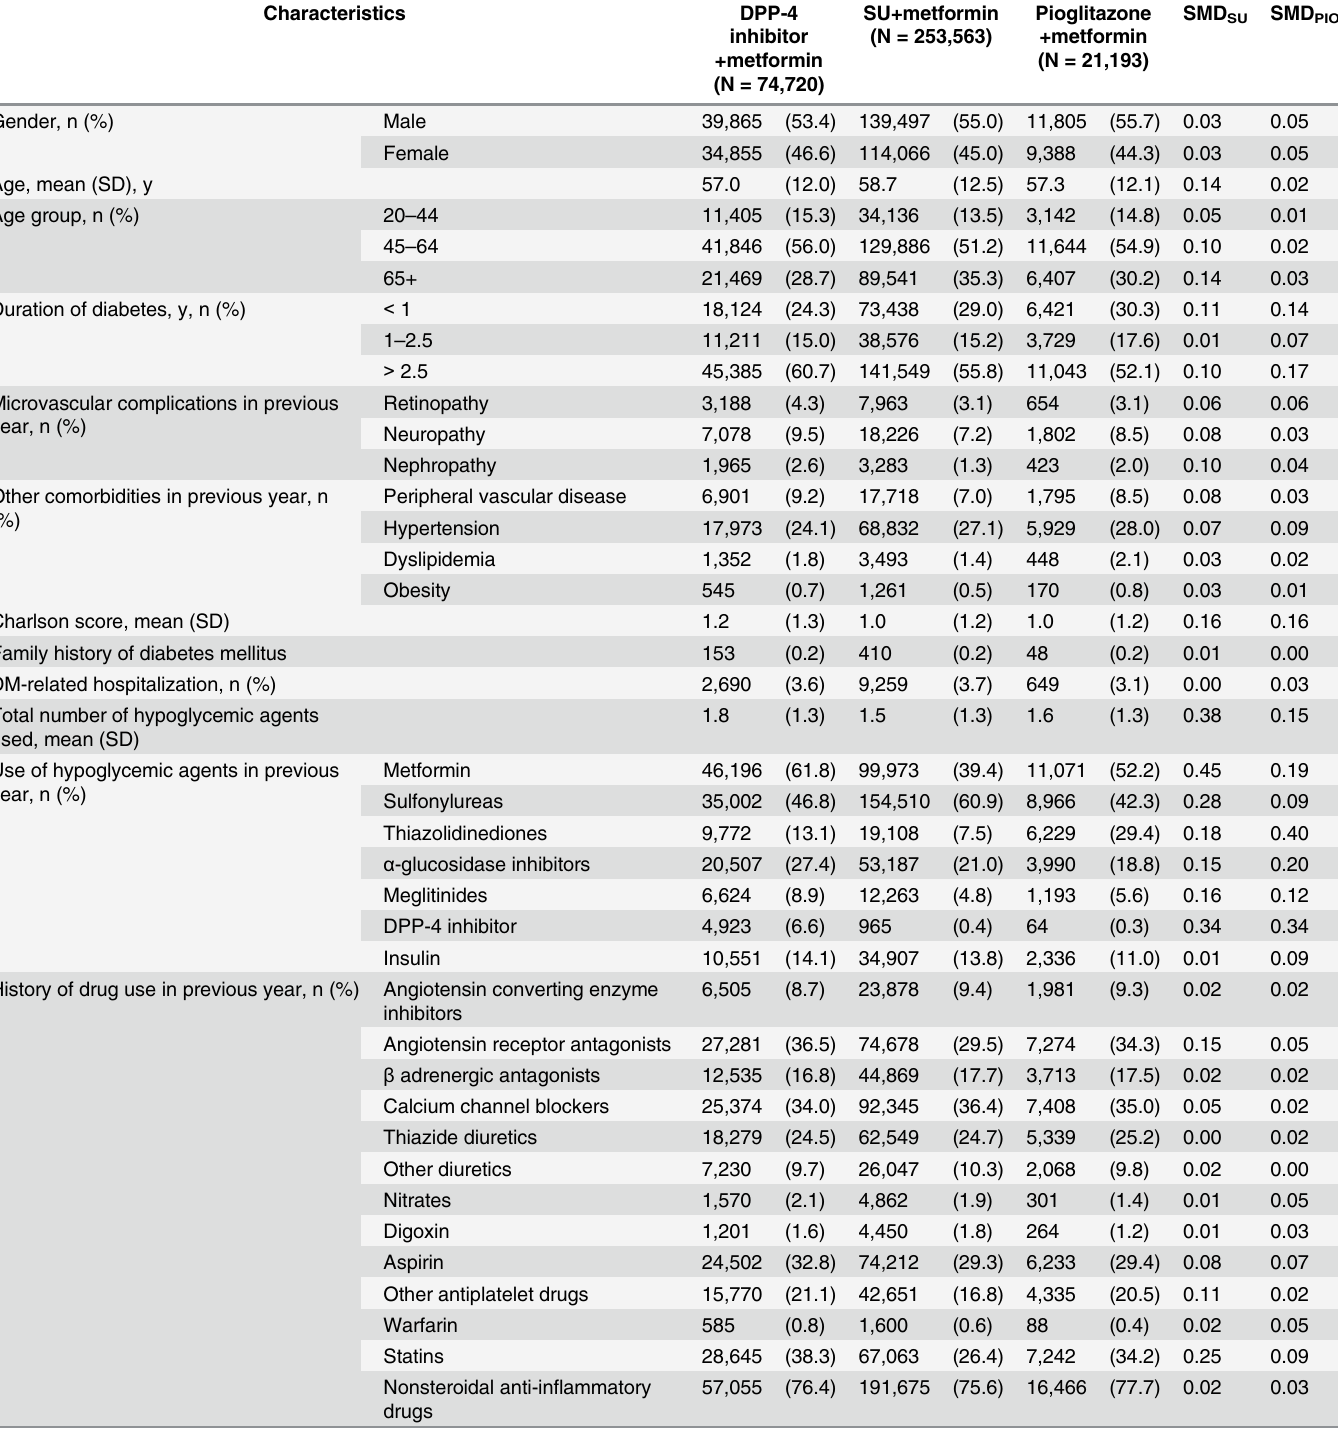
Table 1. Baseline characteristics of the study population.